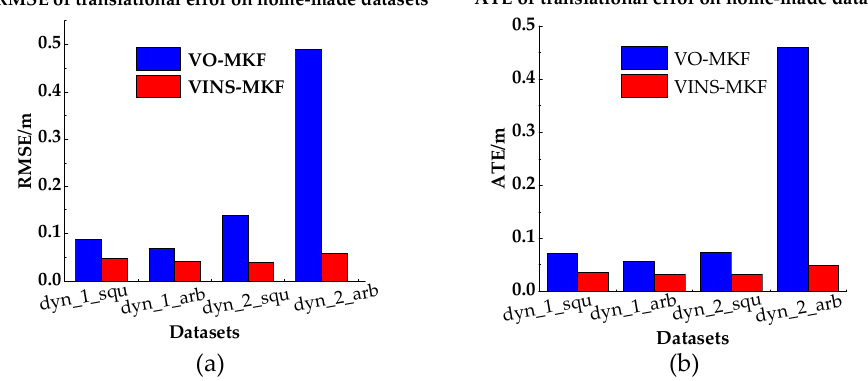
Figure 16. RMSEs and Median ATEs for VINS-MKF, VO-MKF. ( a ) RMSEs of translational error; ( b ) Median ATEs of translation.